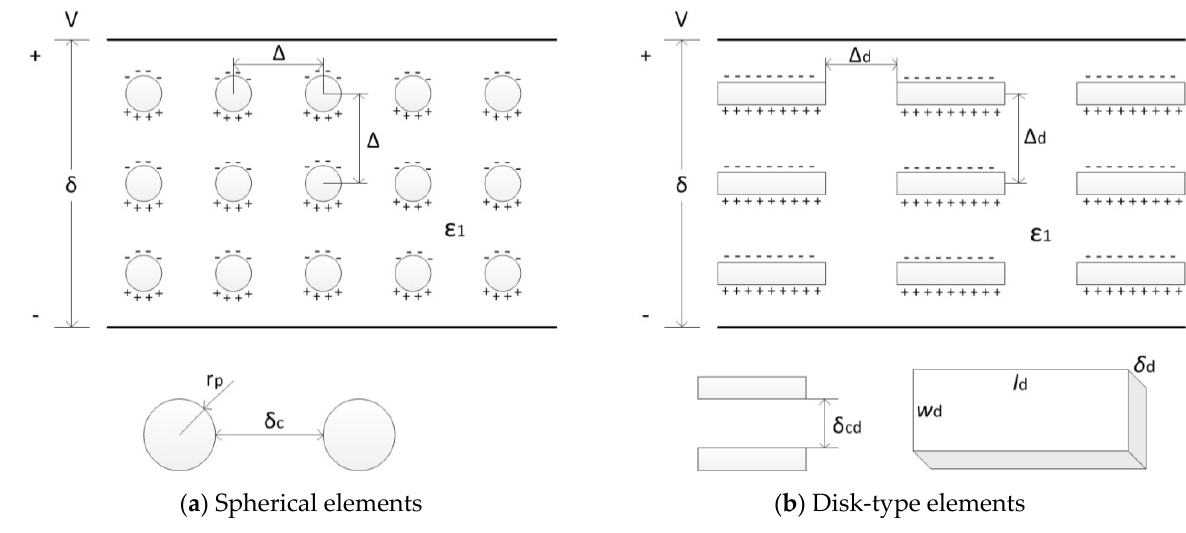
Figure 5. Geometric configurations of the microcaps.